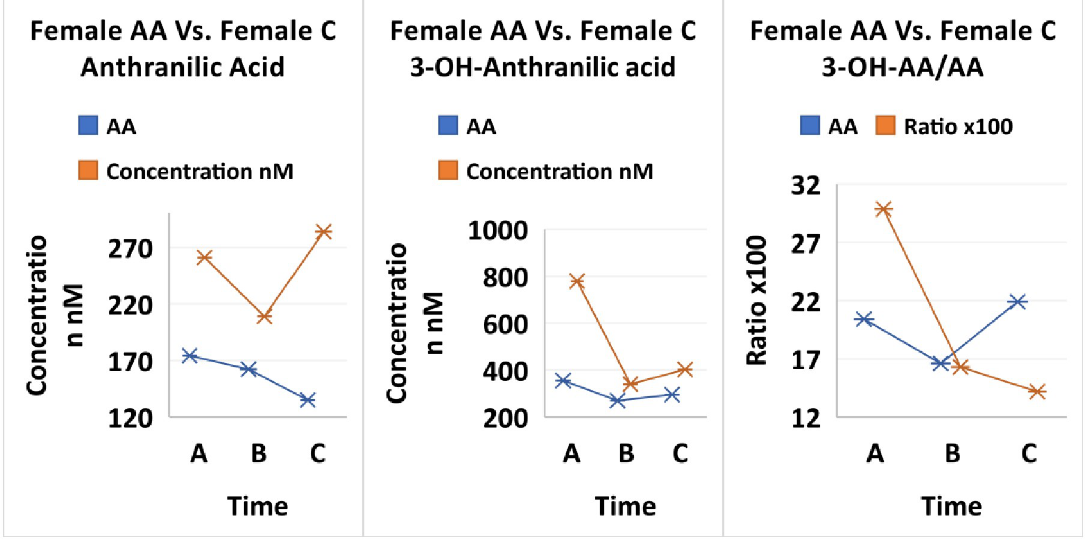
Fig 4. Comparison of treatment over 3 time points Time A at 6-12hours, Time B at 2 weeks and Time C at 3 months between African American females and Caucasian females for 3-OH-antrhranilic acid (3OHAA), anthranilic acid (AA), and 3OHAA/AA.